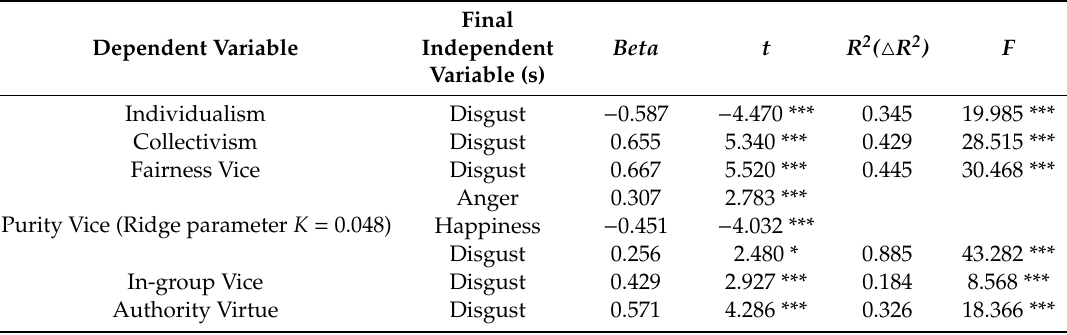
Table 7. Details of multiple regression—emotions and moral concern / cultural